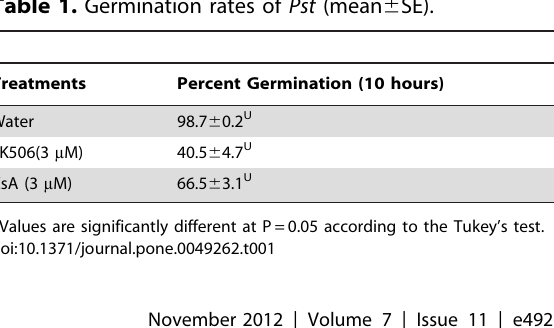
Table 1. Germination rates of Pst (mean 6